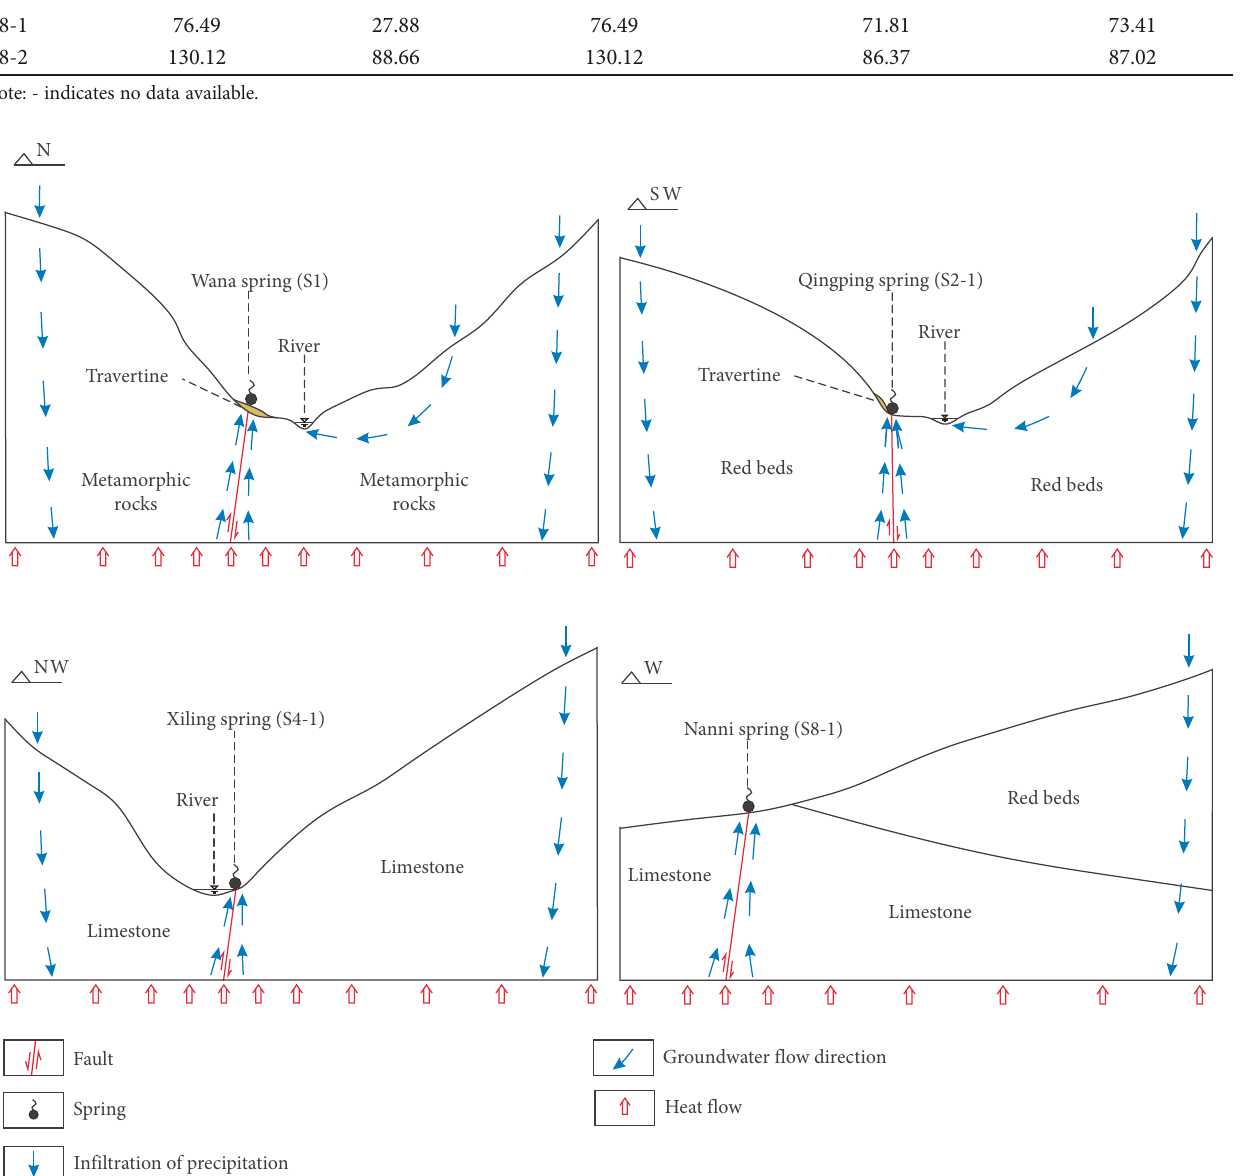
Figure 15: Schematic pro fi les showing the formation of the select hot springs in the Simao